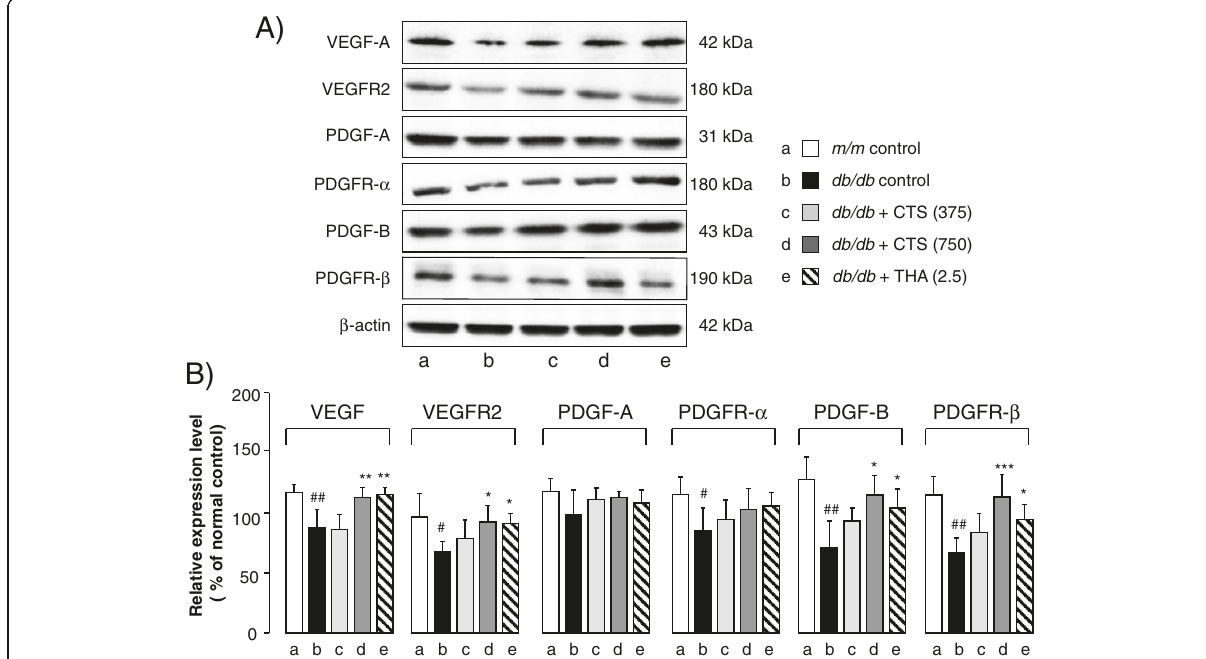
Figure 7 Effects of CTS and THA on VEGF/VEGFR2 and PDGF/PDGFR expression in the hippocampus of db/db mouse. A ) Typical photos indicating the expression levels of each factor in the hippocampus of vehicle-treated m/m (lane a), and vehicle (lane b)-, CTS (325 mg/kg per day: lane c; 750 mg/kg per day: lane d)-, and THA (2.5 mg/kg per day; lane e)-treated db/db mice. B ) Quantitative comparisons of each factor among different animal groups were conducted as described in the text. The data are expressed as the percentage of the value obtained from naïve control m/m mice. Each data column represents the mean ± S.D. obtained from 5 – 6 brain samples. # P < 0.05, ## P < 0.01 vs. vehicle-treated m/m group (Student ’ s t -test). * P < 0.05, ** P < 0.01, *** P < 0.001 vs. respective vehicle-treated db/db group (one-way ANOVA followed by Tukey